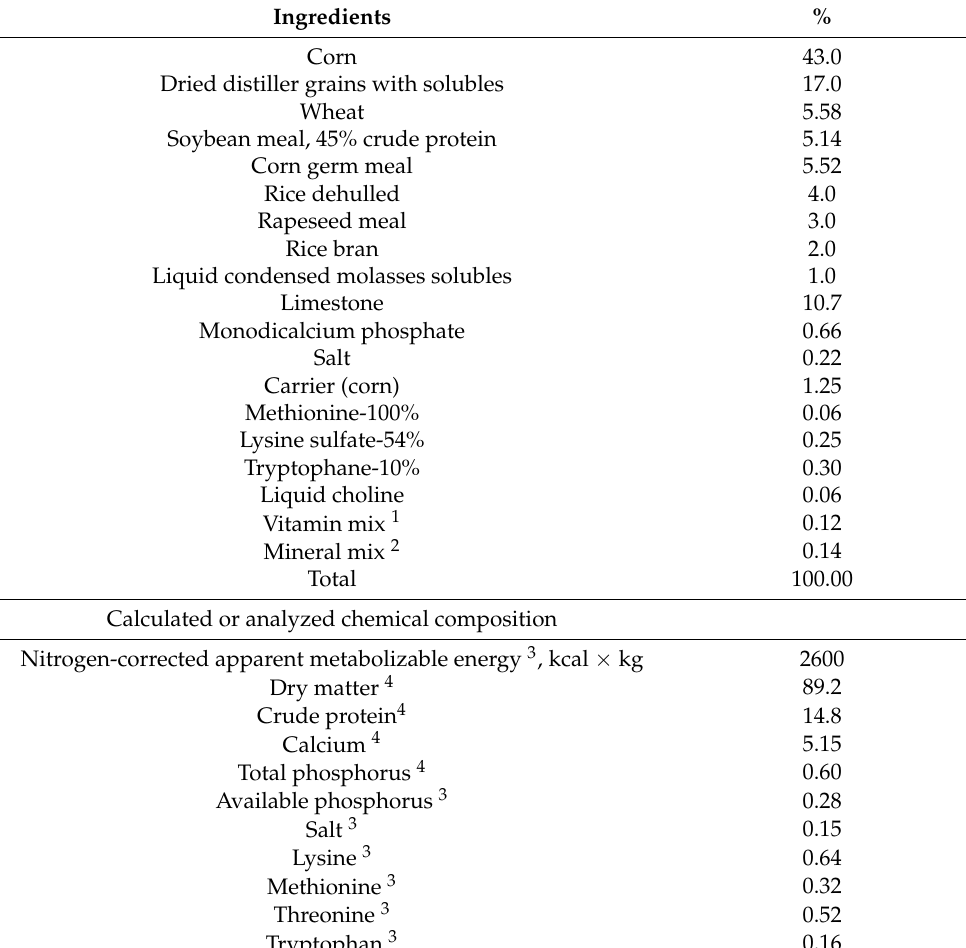
Table 1. Ingredient and chemical composition of the basal